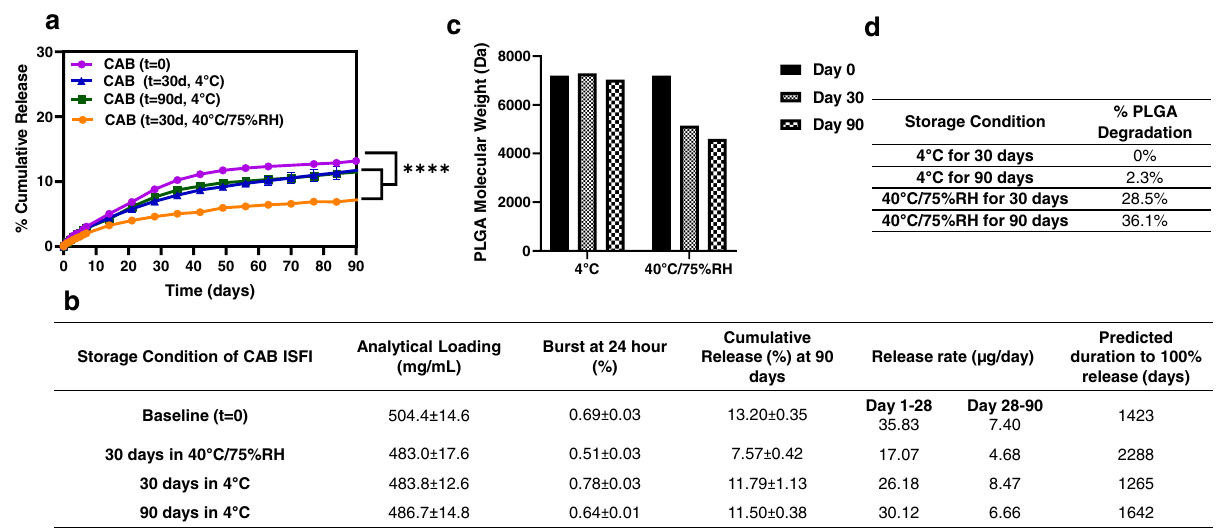
Fig.2|CABISFIstabilityandpost-storageinvitroreleasekinetics.a Cumulative in vitro release kinetics of CAB ISFI (500mg/mL CAB (1:4 w/w PLGA (10kDa):sol- vent)) at baseline ( t =0), 30 days, and 90 days post-storage at 4°C and 40°C/75% RH. All in vitro release studies were done in phosphate buffer saline (PBS, pH 7.4 with 2% Solutol) at 37°C. Data presented as average±standard deviation for n =3 samples. Statistical analysis: two-way ANOVA with Tukey ’ s multiple compar- isonscomparingCABreleasewithrespecttoformulationandtimepoint.Byday90 Figure2aandbshowpost-storageinvitroreleasekineticsobtained